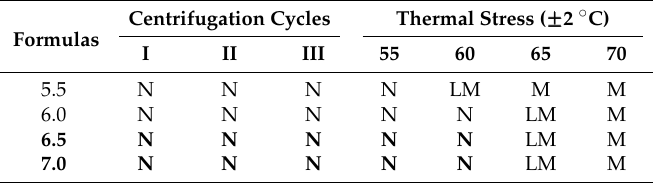
Table 3. Results for preliminary stability tests of